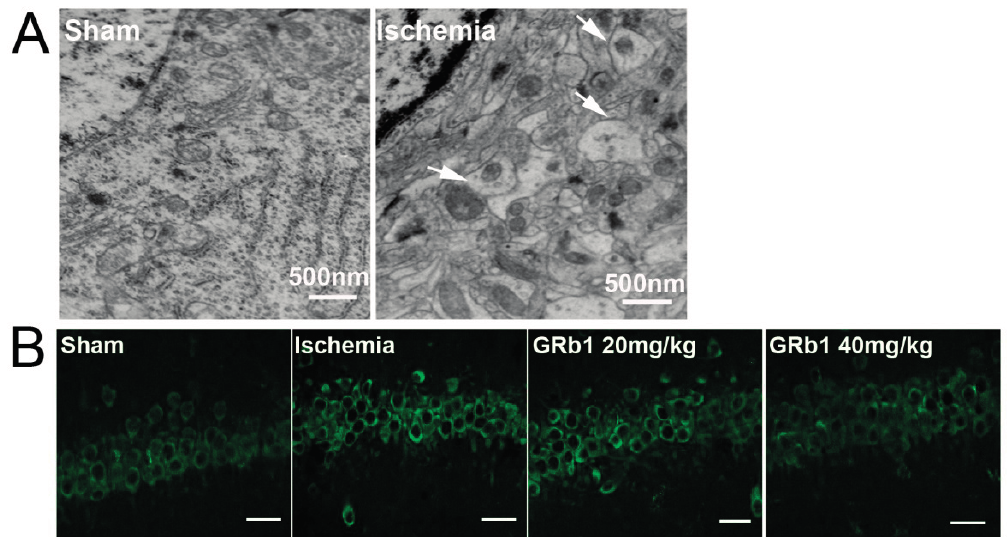
( A ) Images of CA1 neurons under transmission electron microscope. Compared with sham groups, many vacuoles contained mitochondria formed in the cytoplasm in CA1 neurons (indicated by arrows); ( B ) Laser scanning confocal microscopic images of CA1 neurons stained immunochemically with anti-LC3 antibody. Elevated expression of LC3 at reperfusion 24 h following cerebral ischemia was mitigated effectively by pretreatment with GRb1 at doses of 20 and 40 mg/kg. Scale bar = 30 µm; ( C ) Images of western blotting and statistics of optical densities of immunoblots. * p < 0.01 versus OGD group; # p < 0.05 versus OGD group. Each experiment was performed four